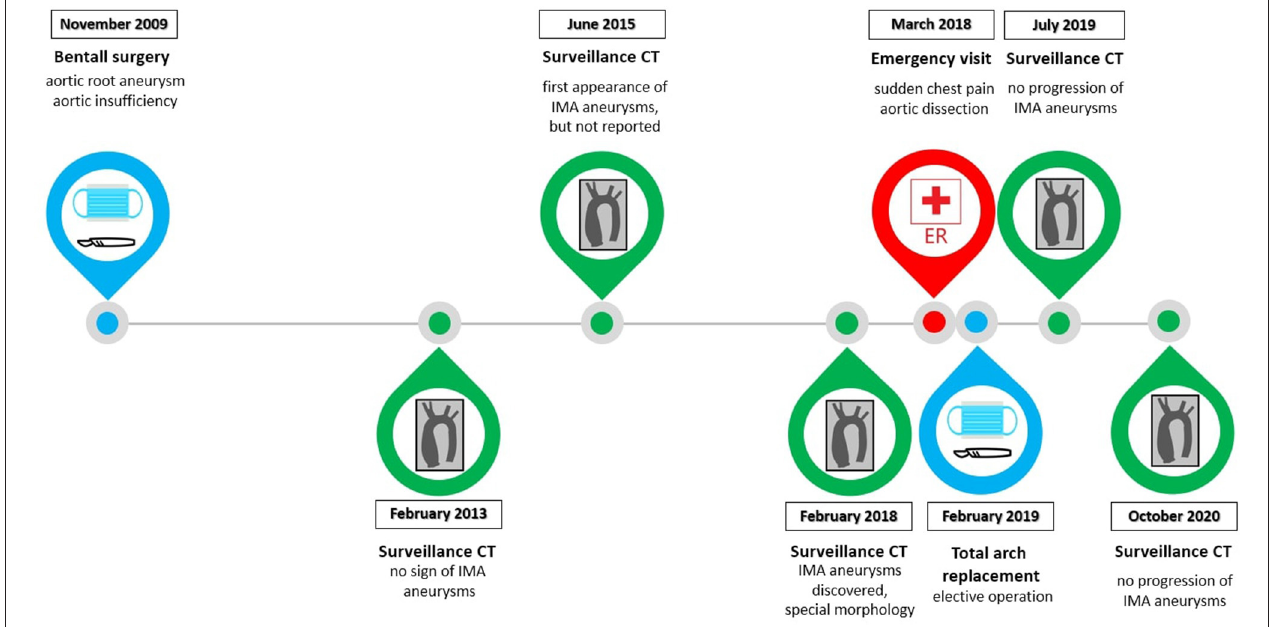
FIGURE 2 | The timeline demonstrates the main episodes of patient care. The key steps of surveillance CT scans are shown, the last one was done in October 2020. The two surgeries and the emergency care were also important aspects in the patient’s